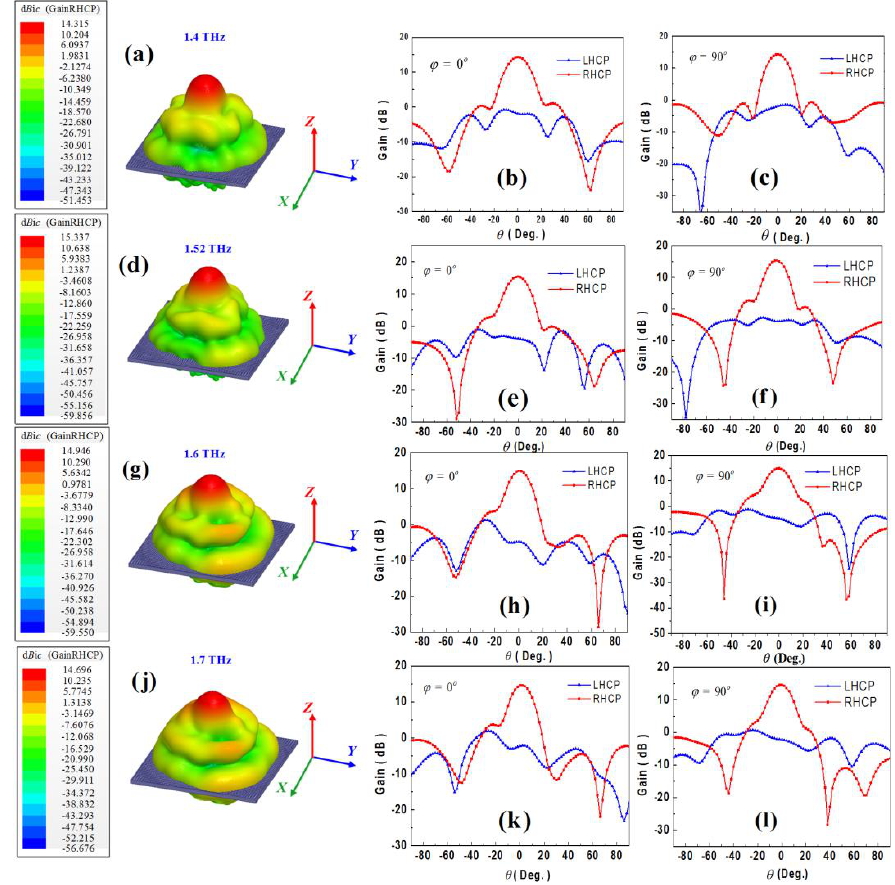
Figure 8. ( a ) 3-D radiation pattern of the proposed reflectarray at 1.4 THz. ( b ) 2-D radiation pattern of the proposed reflectarray at 1.4 THz in ϕ = 0° plane. ( c ) 2-D radiation pattern of the proposed reflectarray at 1.4 THz in ϕ = 90° plane. ( d ) 3-D radiation pattern of the proposed reflectarray at 1.52 THz. ( e ) 2-D radiation pattern of the proposed reflectarray at 1.52 THz in ϕ = 0° plane. ( f ) 2-D radiation pattern of the proposed reflectarray at 1.52 THz in ϕ = 90° plane. ( g ) 3-D radiation pattern of the proposed reflectarray at 1.6 THz. ( h ) 2-D radiation pattern of the proposed reflectarray at 1.6 THz in ϕ = 0° plane. ( i ) 2-D radiation pattern of the proposed reflectarray at 1.6 THz in ϕ = 90° plane. ( j ) 3-D radiation pattern of the proposed reflectarray at 1.7 THz. ( k ) 2-D radiation pattern of the proposed reflectarray at 1.7 THz in ϕ = 0° plane. ( l ) 2-D radiation pattern of the proposed reflectarray at 1.7 THz in ϕ = 90° plane.